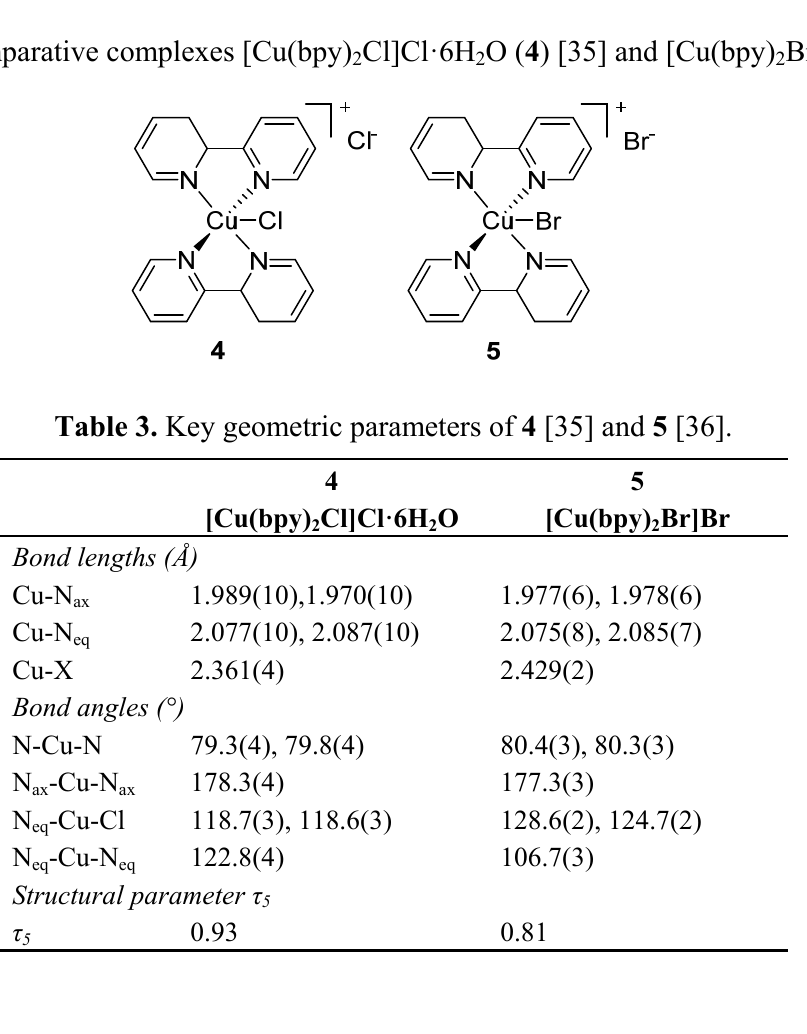
Figure 5. Comparative complexes [Cu(bpy)